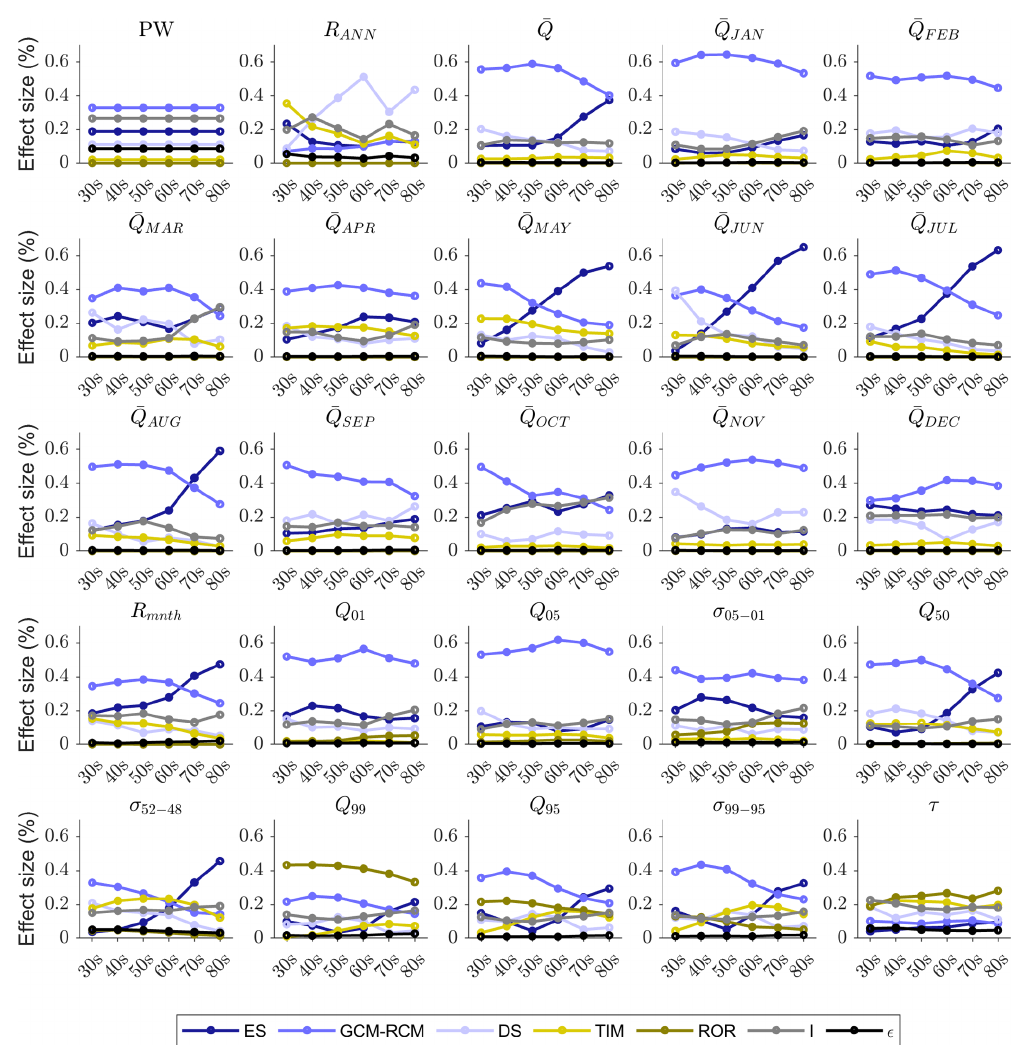
Figure D1. Effect size of all main effects, interactions and remaining error on projected decadal changes in the 25 river discharge signatures for all future time slices centred on the 2030s to the